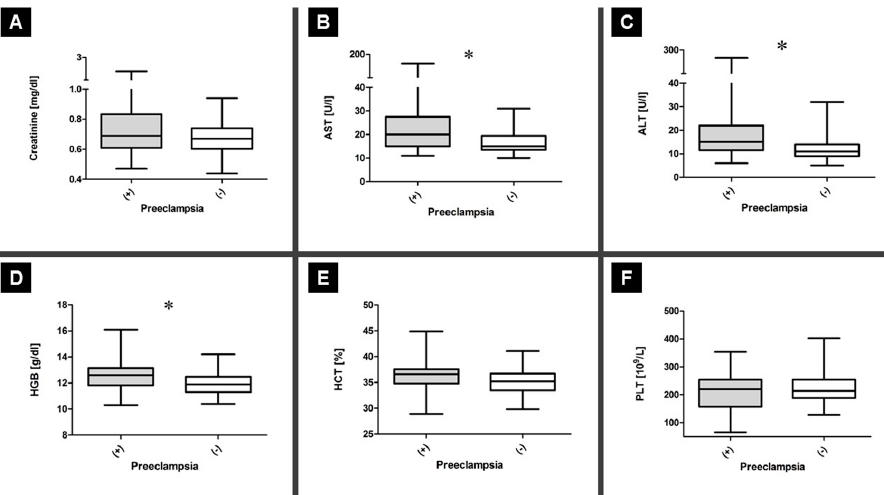
Figure 3 . General biochemistry testing. The levels of creatinine ( A ), AST ( B ), ALT ( C ), hemoglobin (Hgb0) ( D ), hematocrit (HCT) ( E ), and platelet count (PLT) ( F ) were compared between the PE and GH groups. Significant differences in AST, ALT, and PLT (F) were compared between the PE and the GH groups. Significant differences in AST, ALT, and platelet count were noted and indicated with “*”; * p < 0.05.